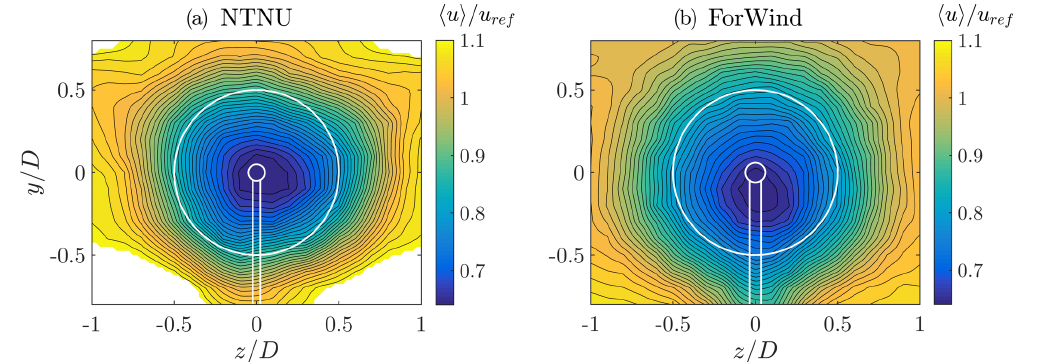
Figure 5. (cid:104) u (cid:105) /u ref at γ = 0 ◦ for the NTNU turbine (a) and ForWind turbine (b) . The white lines indicate the contours of the respective turbine. Values exceeding (cid:104) u (cid:105) /u ref = 1 . 1 are